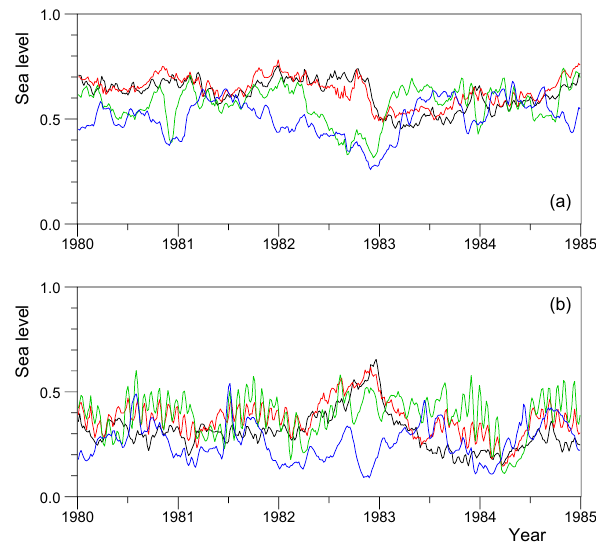
Figure 18. Sea surface height (m) at longitudes: (a) 168 ◦ E, (b) 230 ◦ E, and latitudes: (black) the Equator, (red) 3 ◦ N, (green) 6 ◦ N and (blue) 9 ◦